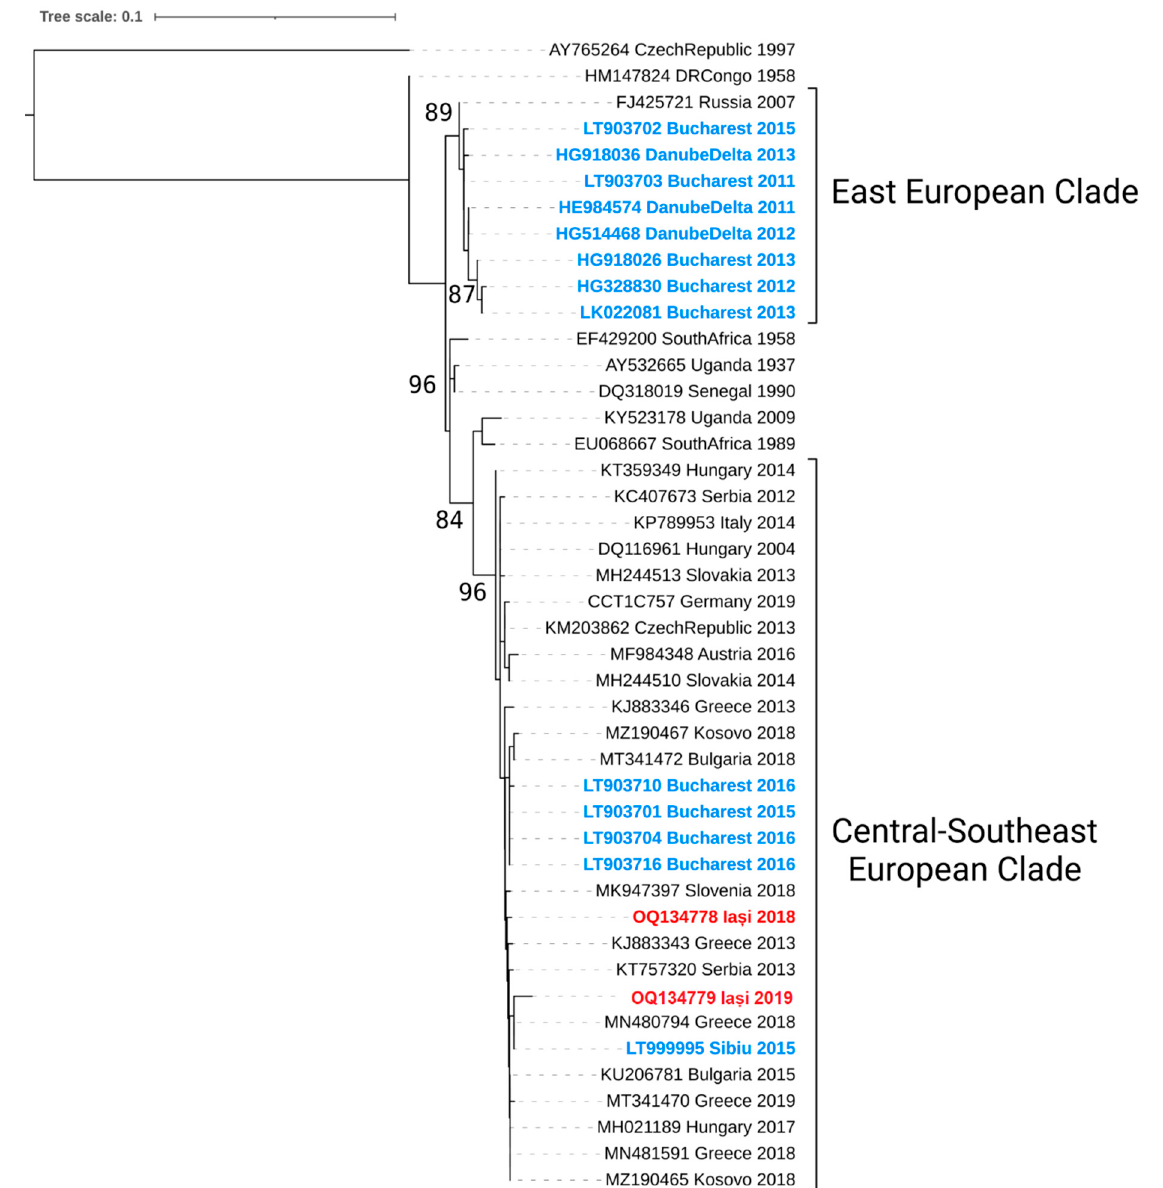
Figure 4. Maximum likelihood phylogenetic analysis of WNV lineage 2 partial NS5 gene. Romanian strains are indicated in blue (previous studies) and red color (present study). Rabensburg strain 97–103 was used as an outgroup, and bootstrap support >80% is displayed at nodes of major clades.